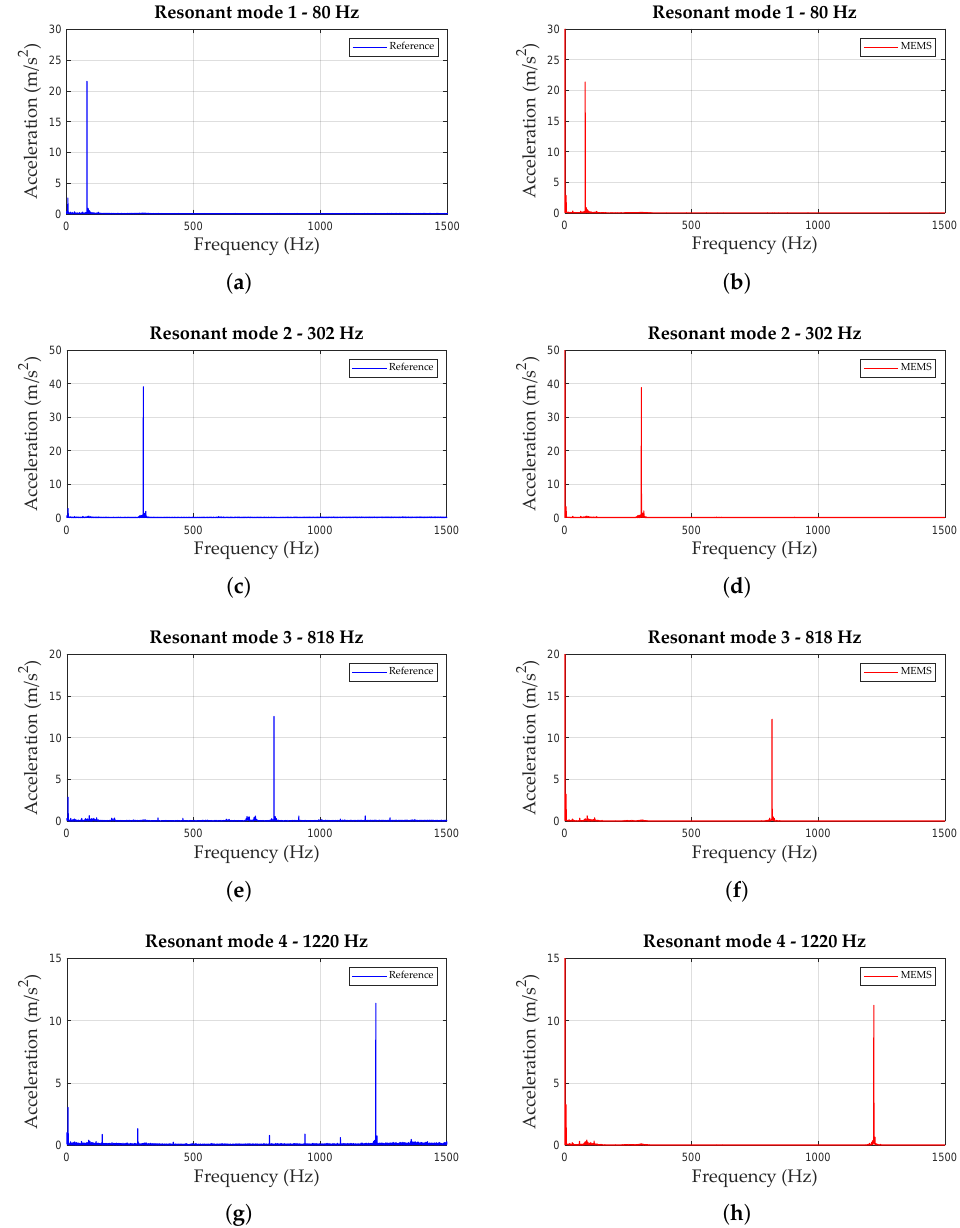
Figure 5. FFT of the reference and MEMS accelerometer signals at a rotor speed of 300 rpm, consider- ing: ( a , b ) the first resonant mode, ( c , d ) the second resonant mode, ( e , f ) the third resonant mode, and ( g , h ) the fourth resonant